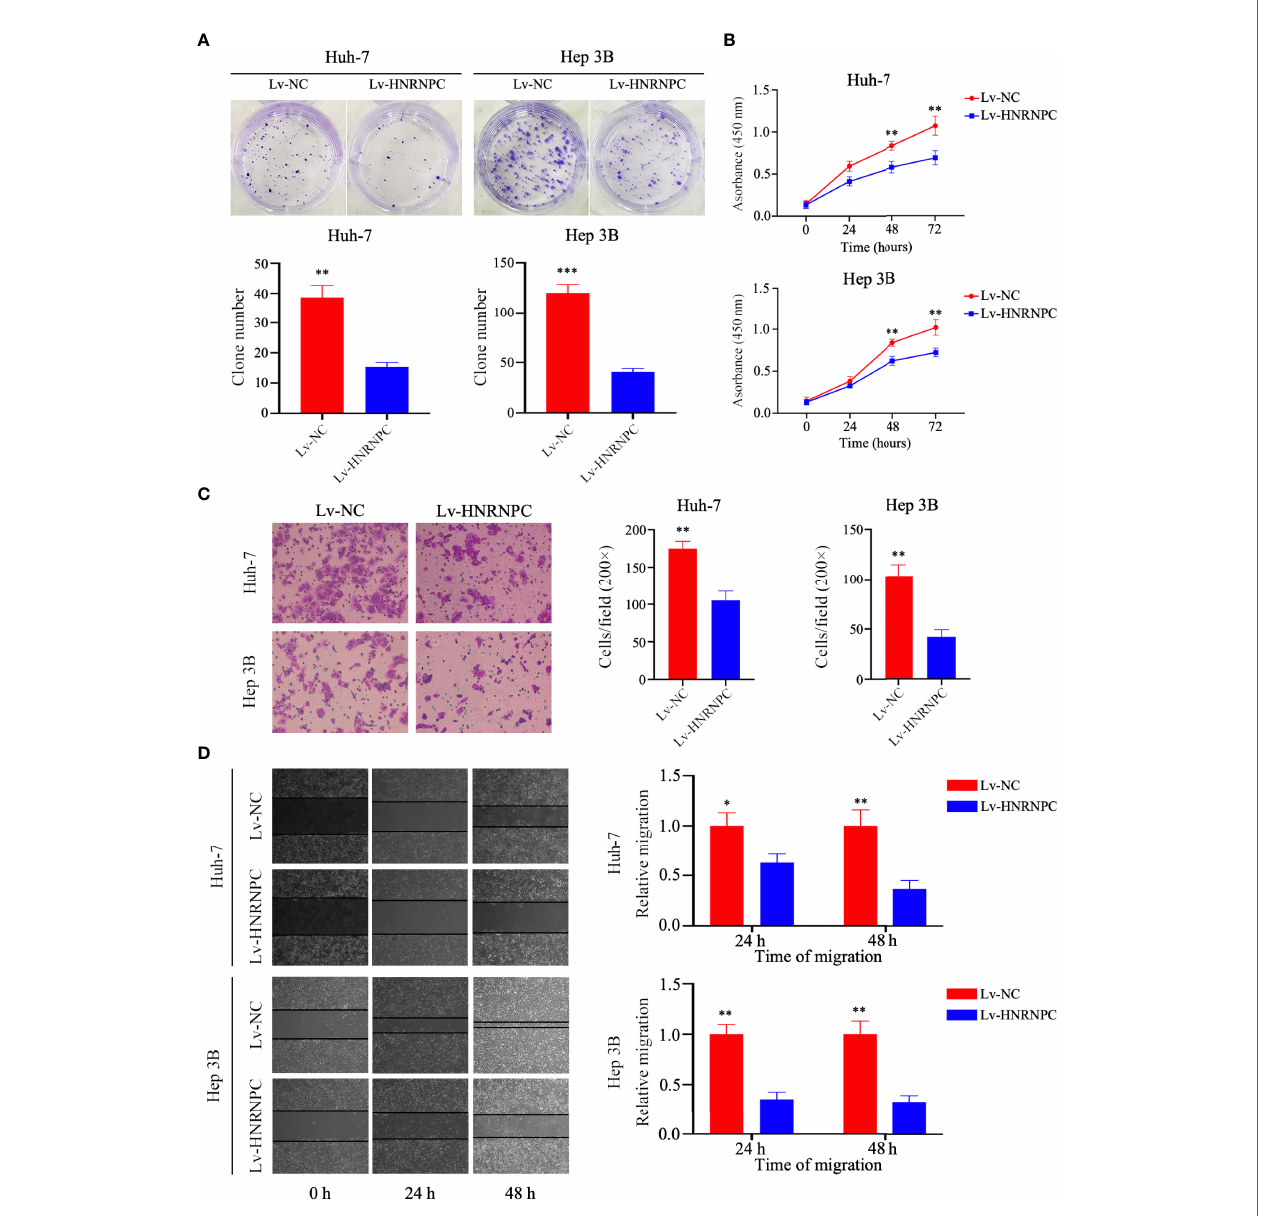
FIGURE 2 | Knockdown of HNRNPC suppressed proliferation, invasion, and migration of HCC cells in vitro . (A) Colony formation assay showing the impact of HNRNPC knockdown on HCC cell proliferation. (B) CCK-8 test showing the effects of HNRNPC downregulation on HCC cell viability. (C) Transwell assay showing the in fl uence of HNRNPC inhibition on HCC cell invasion. (D) Scratch wound test showing the in fl uence of HNRNPC suppression on HCC cell migration. All experiments were independently repeated three times, and the results were showed as mean ± standard deviation (SD). *P < 0.05, **P < 0.01, ***P <